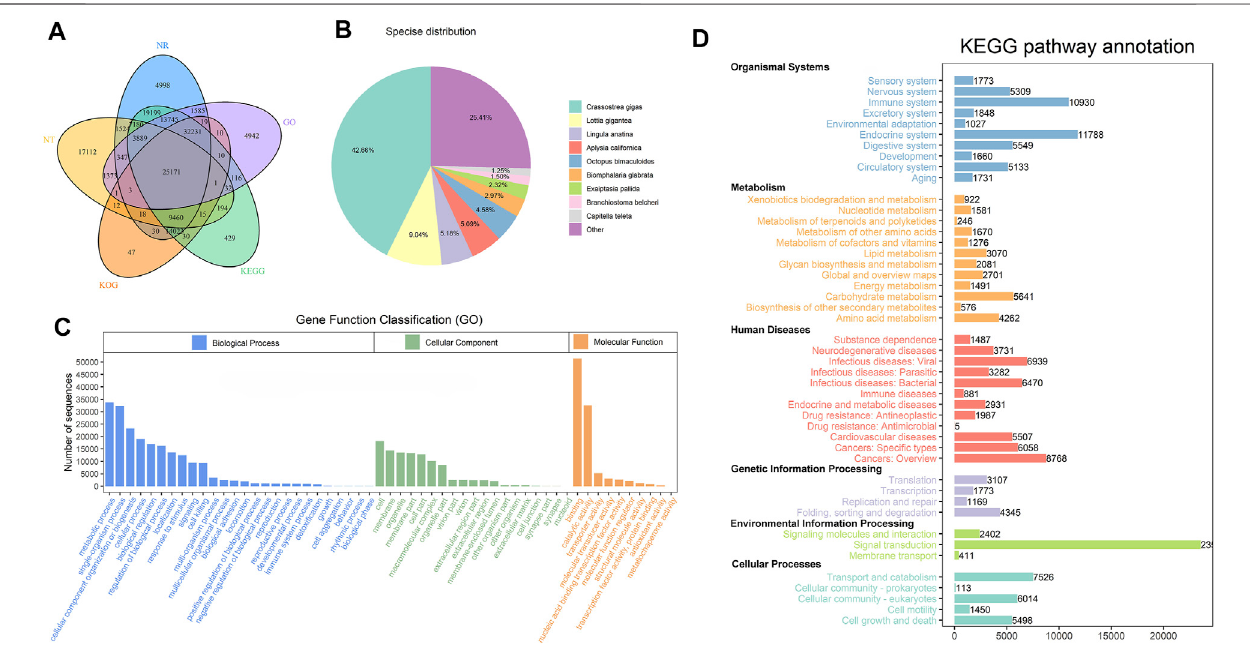
FIGURE3| Annotationoftranscriptsfrom H.schlegelii ’ sgonads. (A) Genefunctionannotationin5databases(Nr,Nt,KOG,KEGG,GO). (B) Homologousspecies distribution of gonad annotated in the NR database. (C) Annotation of the GO function of the gonadal transcript. (D) Annotation of the KEGG function of the gonadal